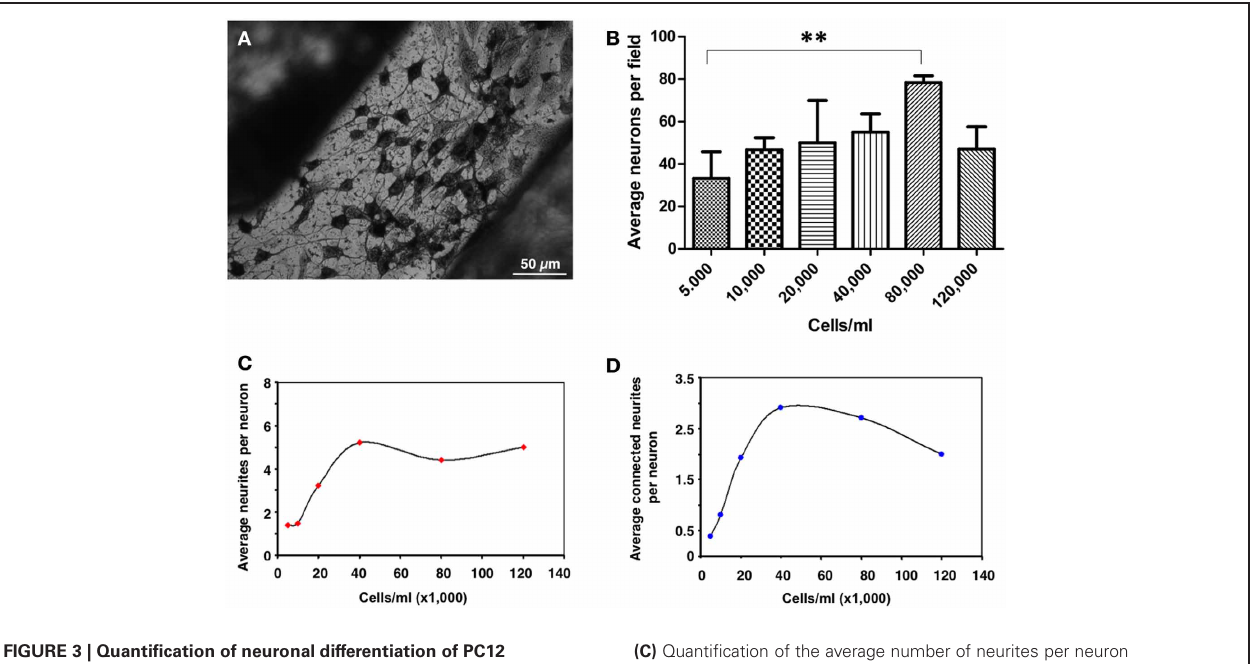
(C) Quantification of the average number of neurites per neuron as a function of cell density. (D) Quantification of the average number of neuritic connections as a function of cell density. At least ten different fields out of three independent experiments were